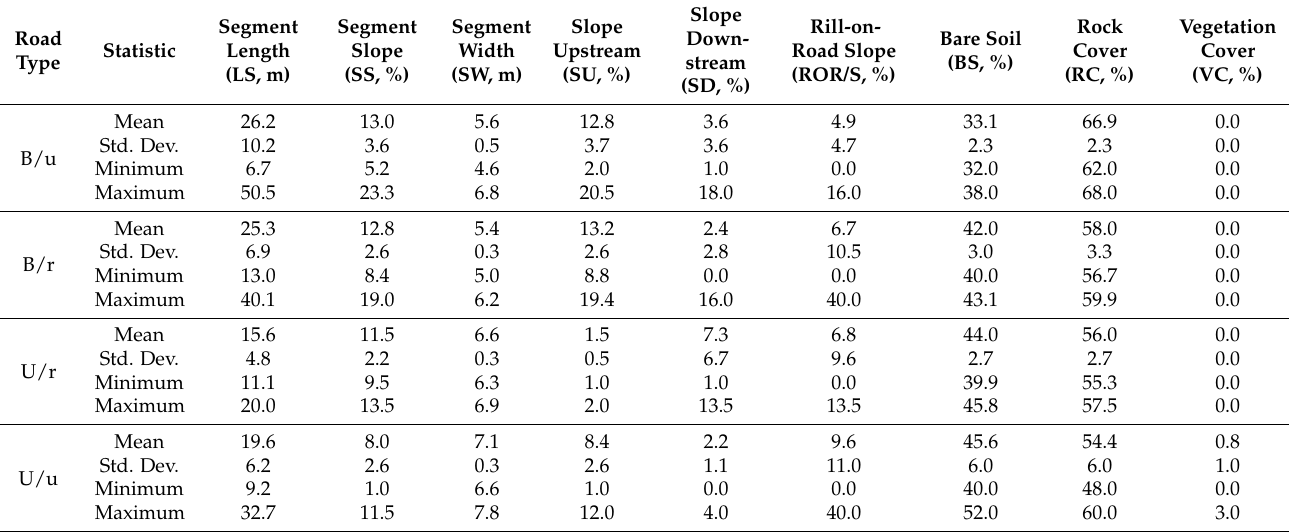
Table 1. Geometric characteristics and soil-covers of the road segments on which erosion/sedimentation volume was measured (Hell ì n, Central-Eastern